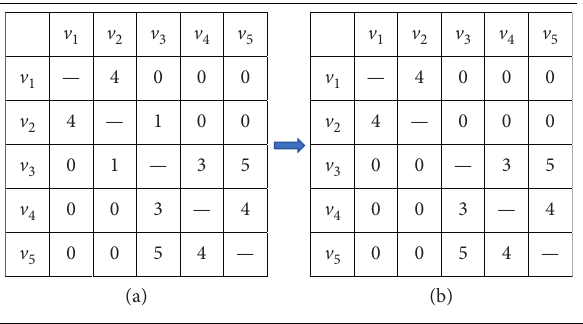
Table 1: An example of Step